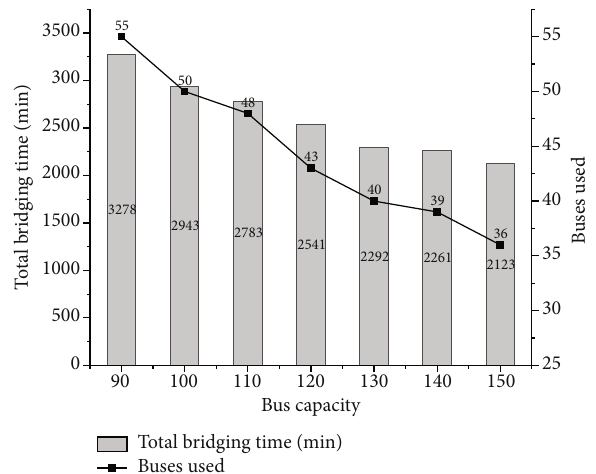
Figure 9: Changes in total bridging time and buses used under di ff erent bus capacity.